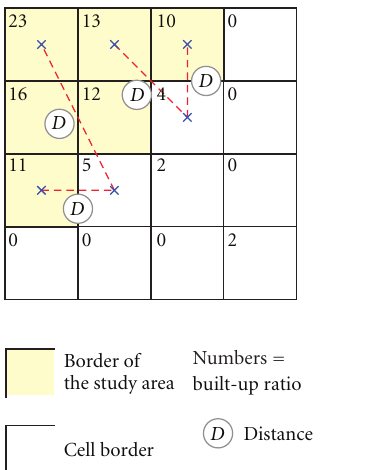
Figure 3: Examples for the determination of the distance ( D ) (built-up ratios are in %).